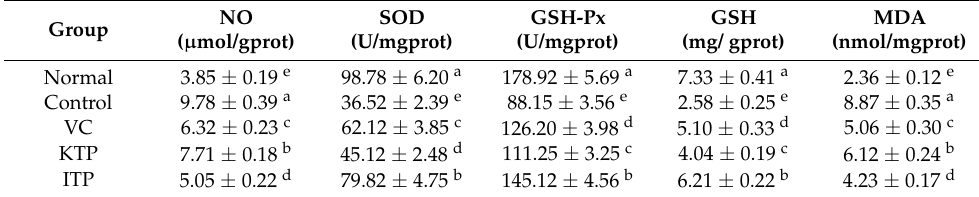
Table 3. Activities of NO, SOD, GSH-Px, GSH and MDA in liver of mice.